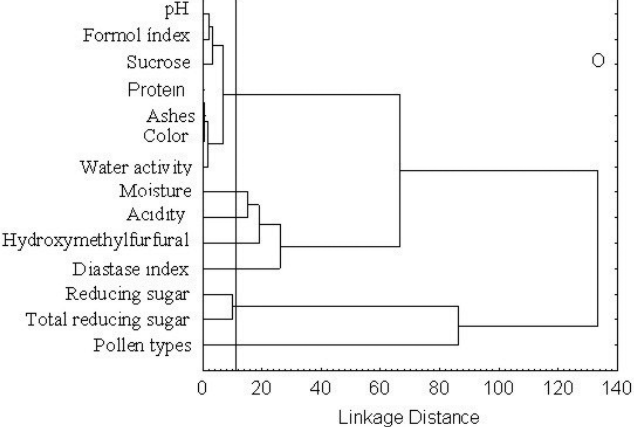
Fig. 1 – Phenogram obtained through the grouping analysis, using the medium Euclidean distance for organic honey samples of A. mellifera and physicochemical parameters selected.